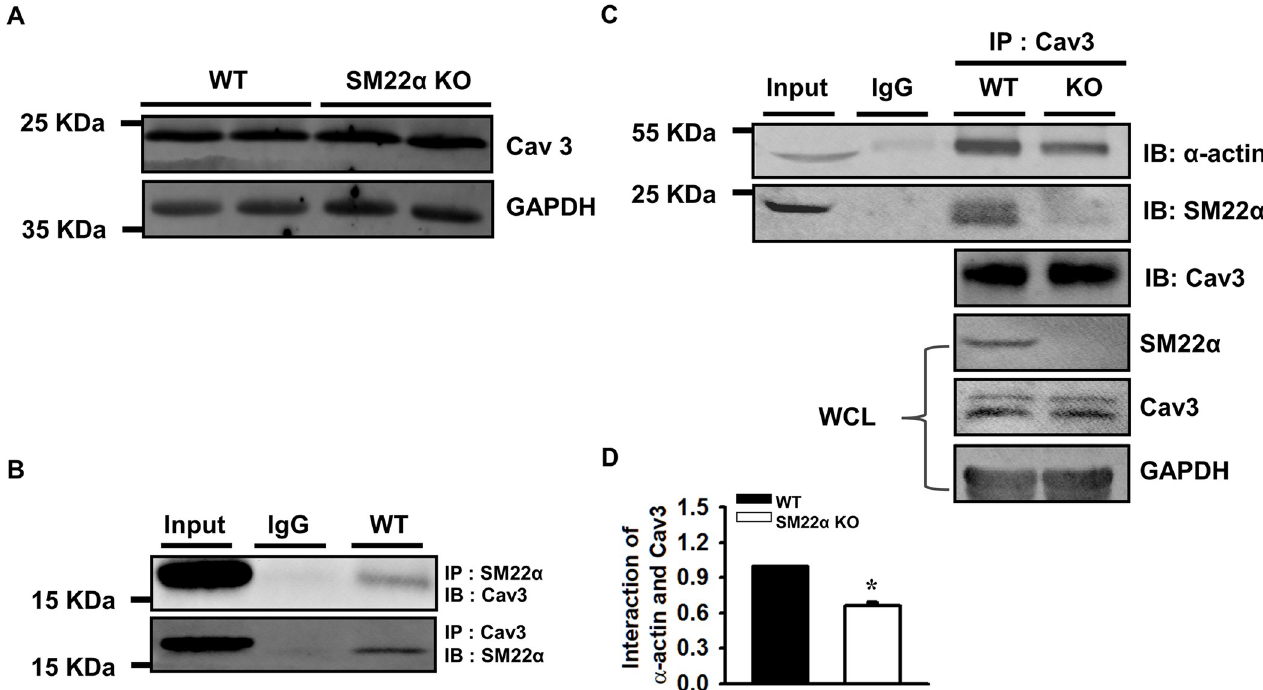
Fig 3. The interaction between actin and Cav3 is decreased in SM22 α KO cardiomyocyte. (A) Western blot for the expression of Cav3. (B, C) Co- immunoprecipitation (co-IP) analysis for the interaction between SM22 α , Cav3 and α -actin. Input lanes correspond to the original extracts used for the co-IP assays. IgG was used as negative control. (D) Bar graphs showed the quantification of α -actin-Cav3 interaction. WCL: whole cell lysate. Data are presented as the mean ± SEM from 3 independent experiments (n = 3). � P < 0.05 vs. WT control.